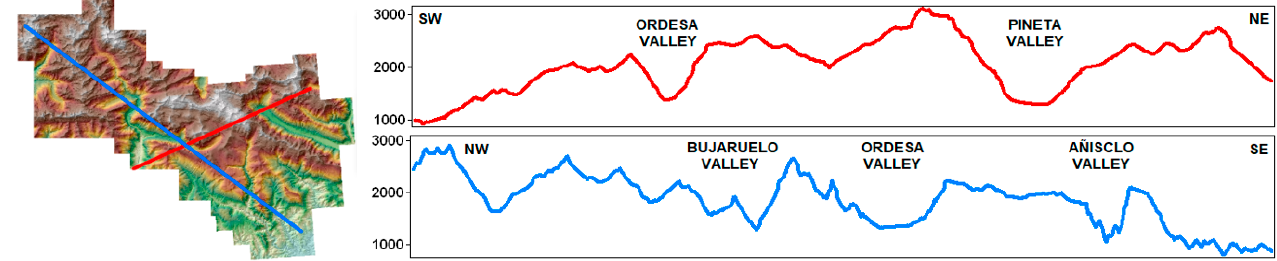
Figure 2. Two different topographic profiles in the study area (PNOMP), showing the rugosity and alternance of high mountains with canyons and valleys.